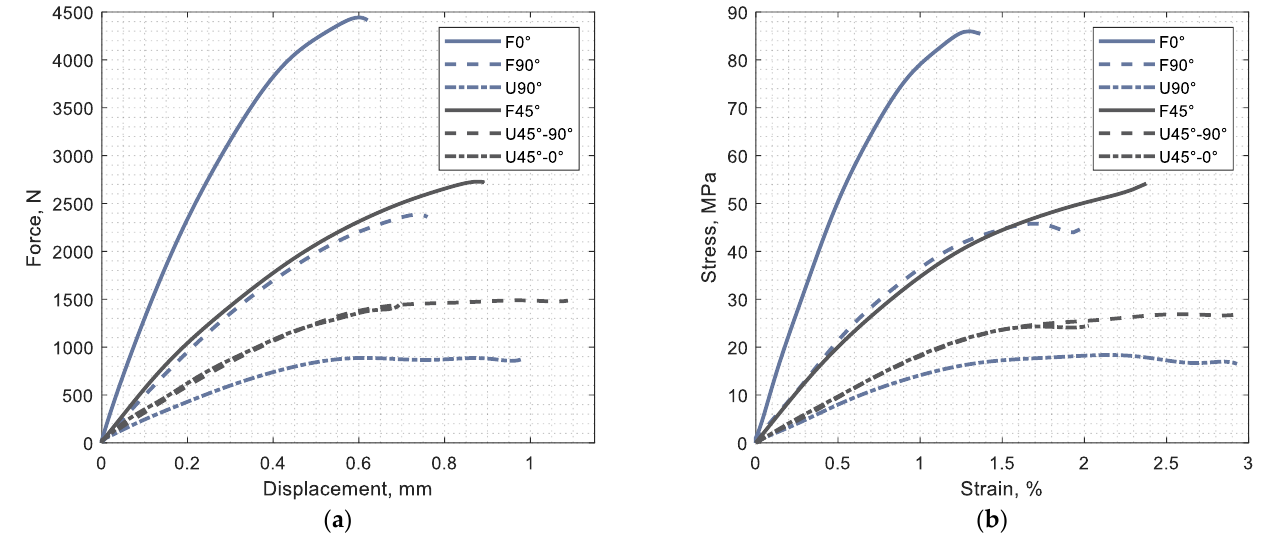
Figure 11. Results of experimental testing, averaged: ( a ) Force-displacement curves; ( b ) stress-strain curves. Table 1. Material parameters determined from experiments,